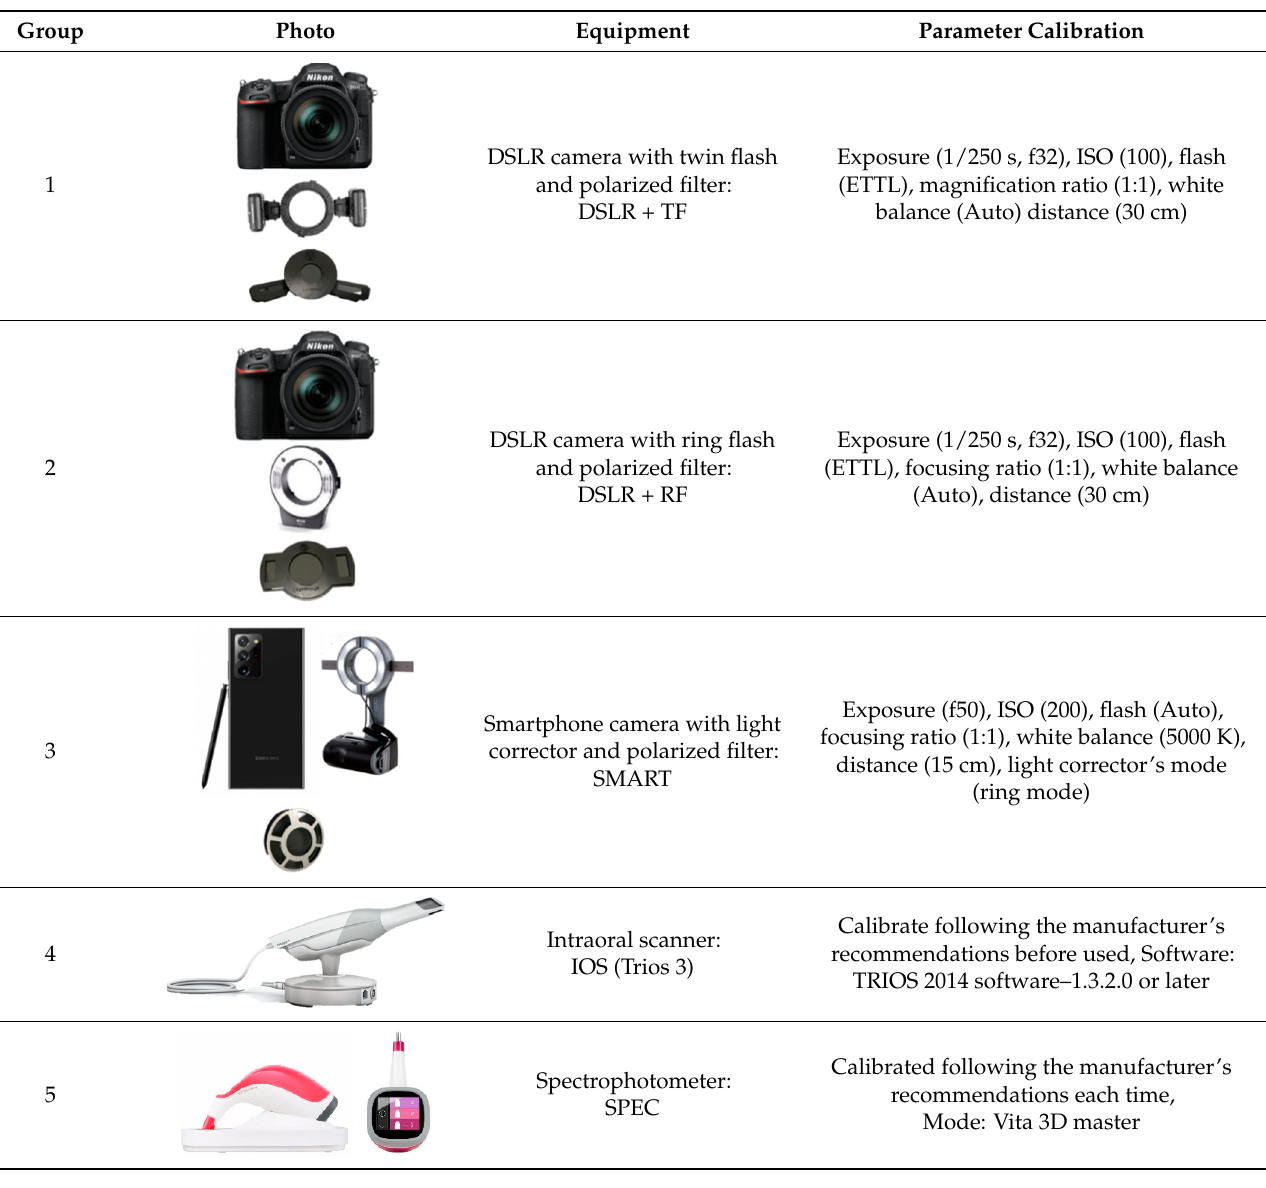
Table 2. Calibration of each method before the experiment.